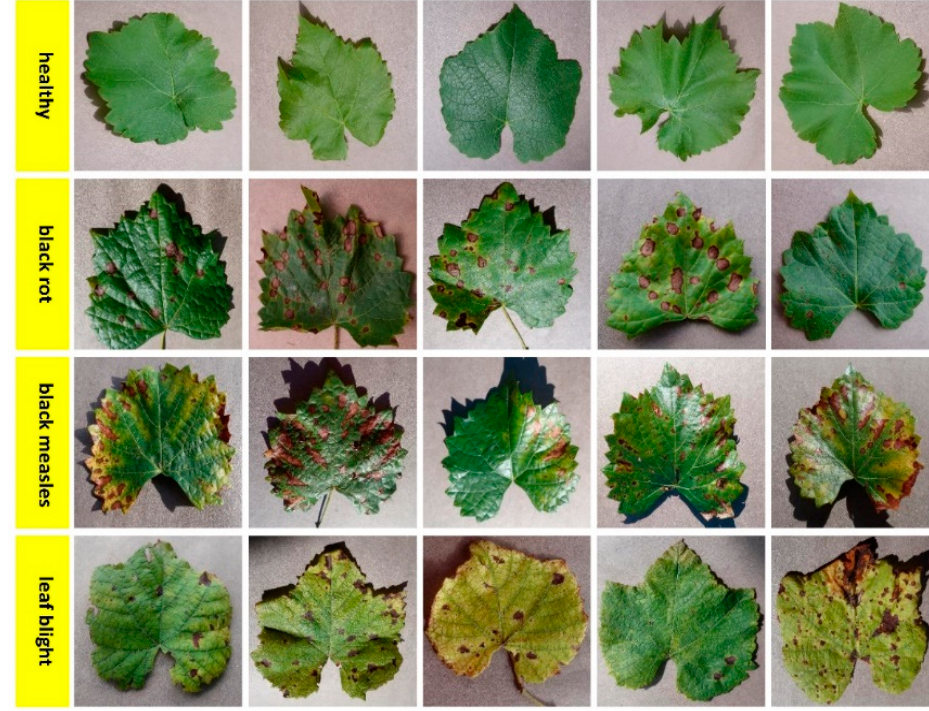
Figure 4. Leaf image examples belonging to healthy and diseased classes of grape plants.